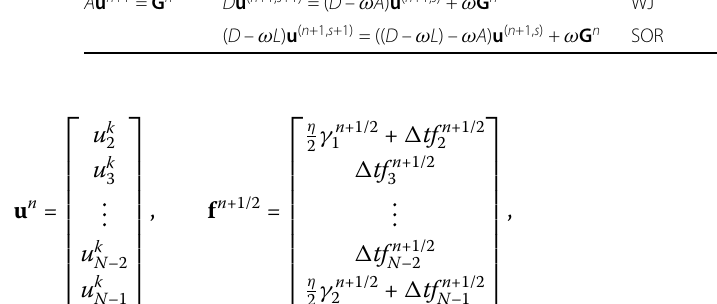
Table 1 The specific name of WJ and SOR in solving linear system (4.5) Linear system Iterative method Specific